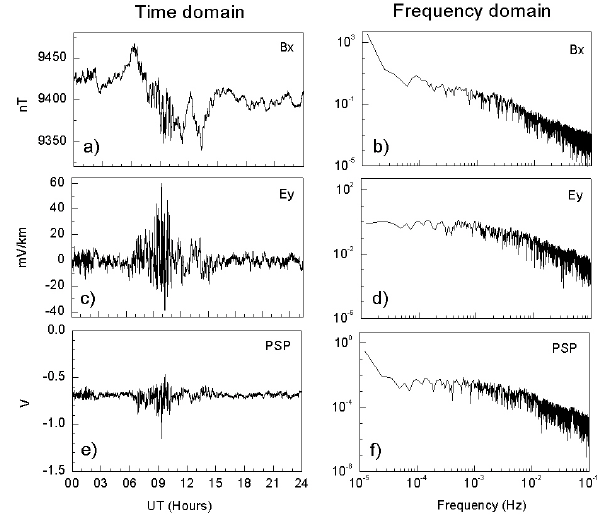
Fig. 9. Modelling results of pipeline response in time-domain and frequency domain. (a) and (b) north-south component of magnetic field (c) and (d) east-west component of the geoelectric field (e) and (f) pipe-to-soil potential at site 340 on Norman Wells – Zama